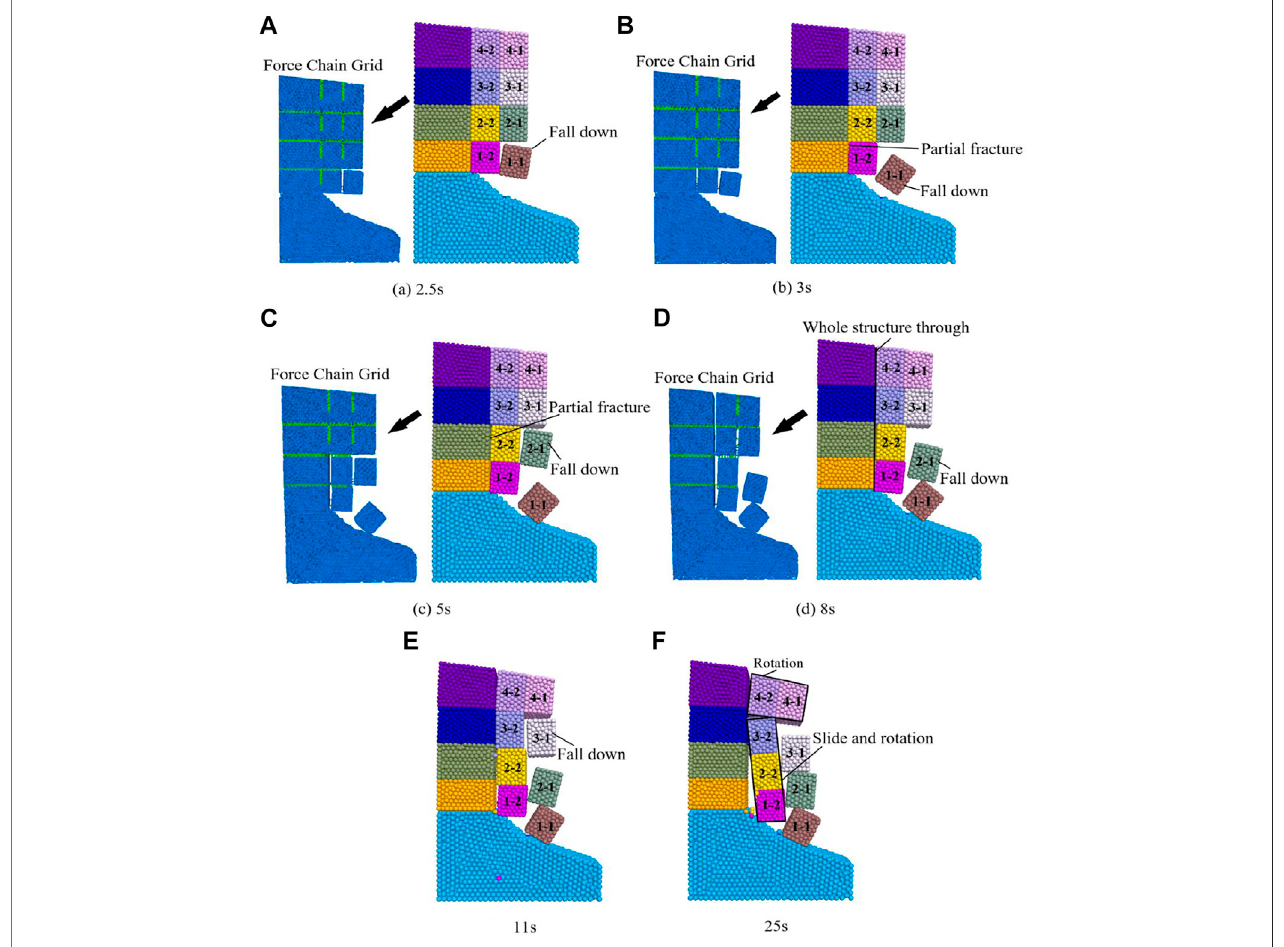
FIGURE 8 | Diagram of the failure process of dangerous rocks.